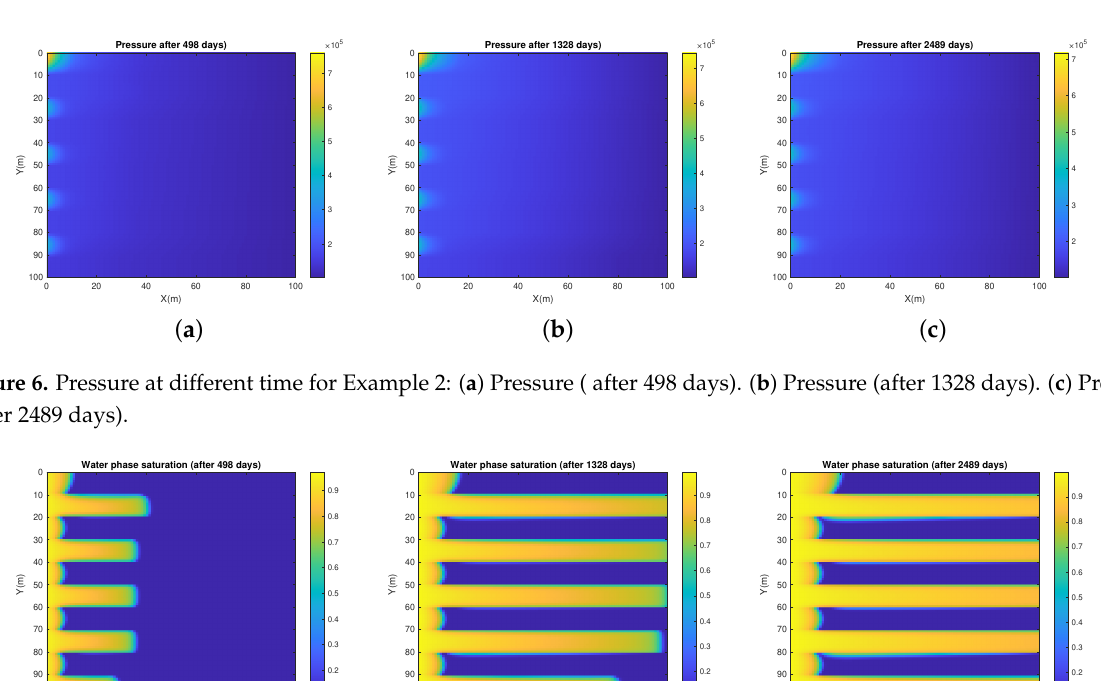
Figure 5. Permeability (md) distribution for Example 2 .